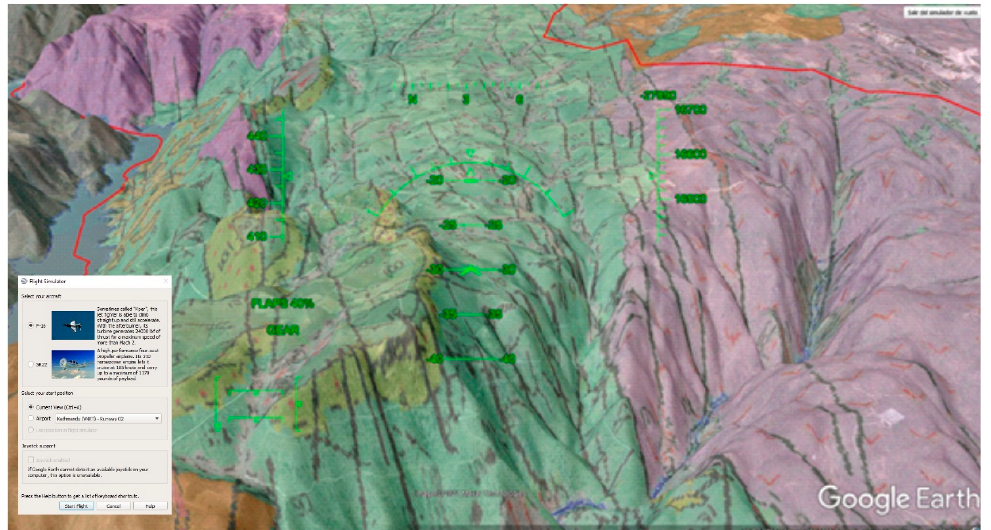
Figure 9. Capture of the virtual flight with the flight simulator of the F-16 plane over the geological distribution near of the site P-11